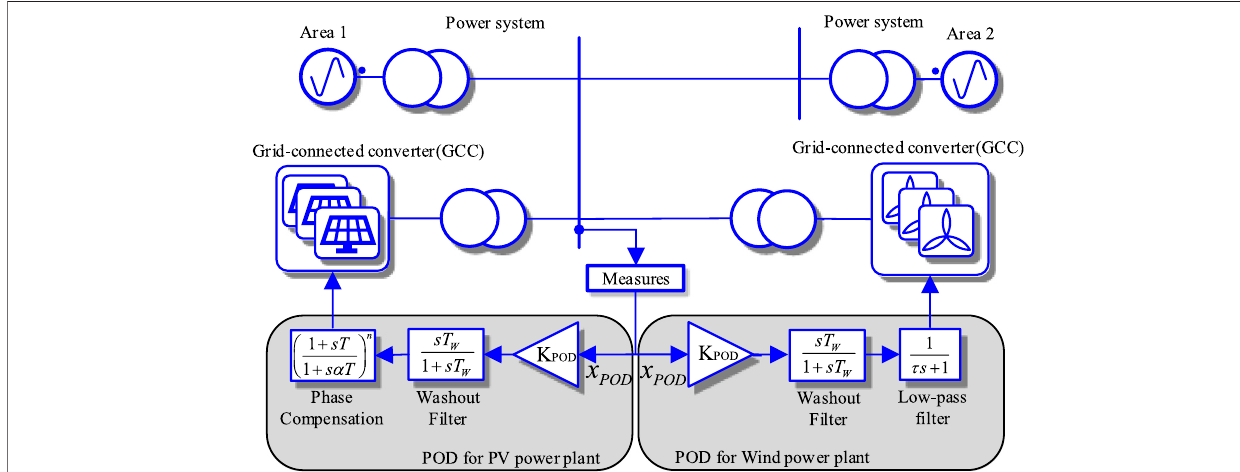
FIGURE 1 | Conventional POD controller for grid-connected converter.